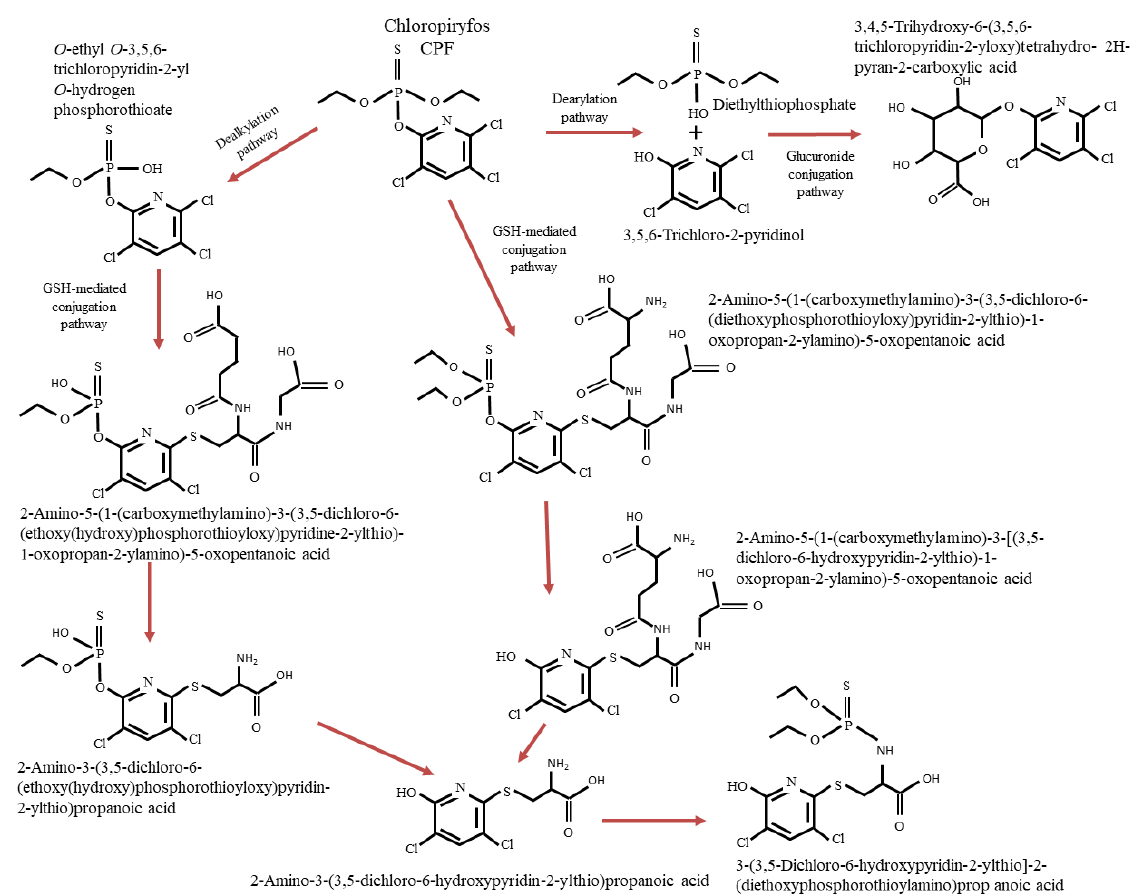
Figure 2. Biotransformation pathways of CPF in hepatocytes [49].